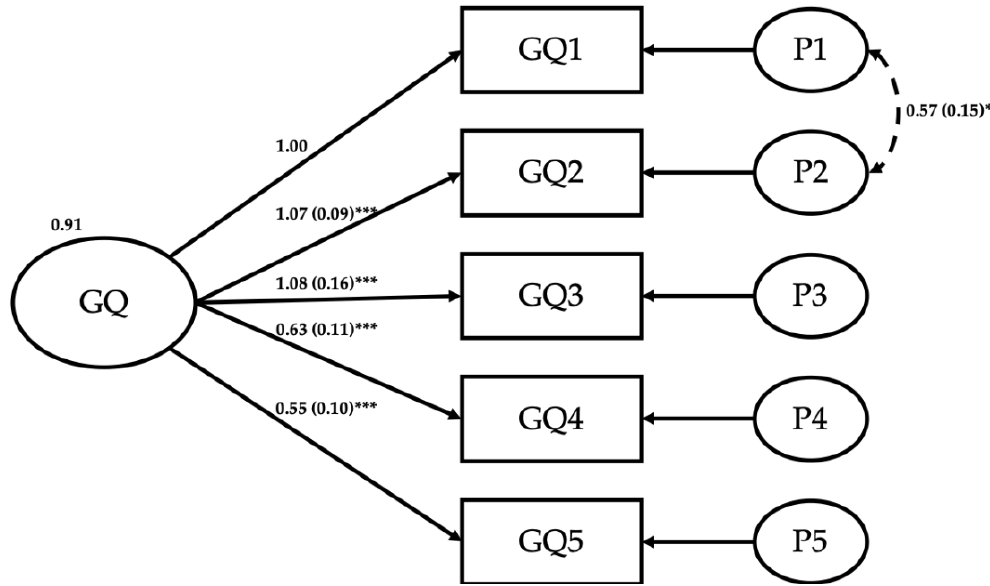
Figure 1. Path model of GQ-6 on full sample (N = 328). Note: GQ6 has been removed from scale due to its poor contribution to the model. *** indicates p < 0.001.